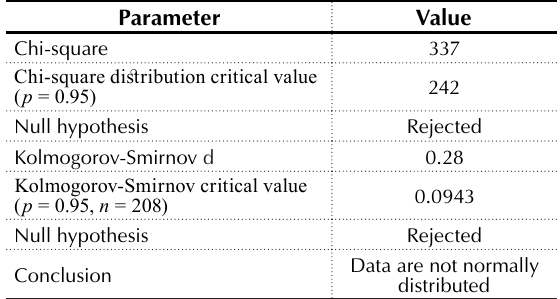
Table 3. “Normality” test of the data